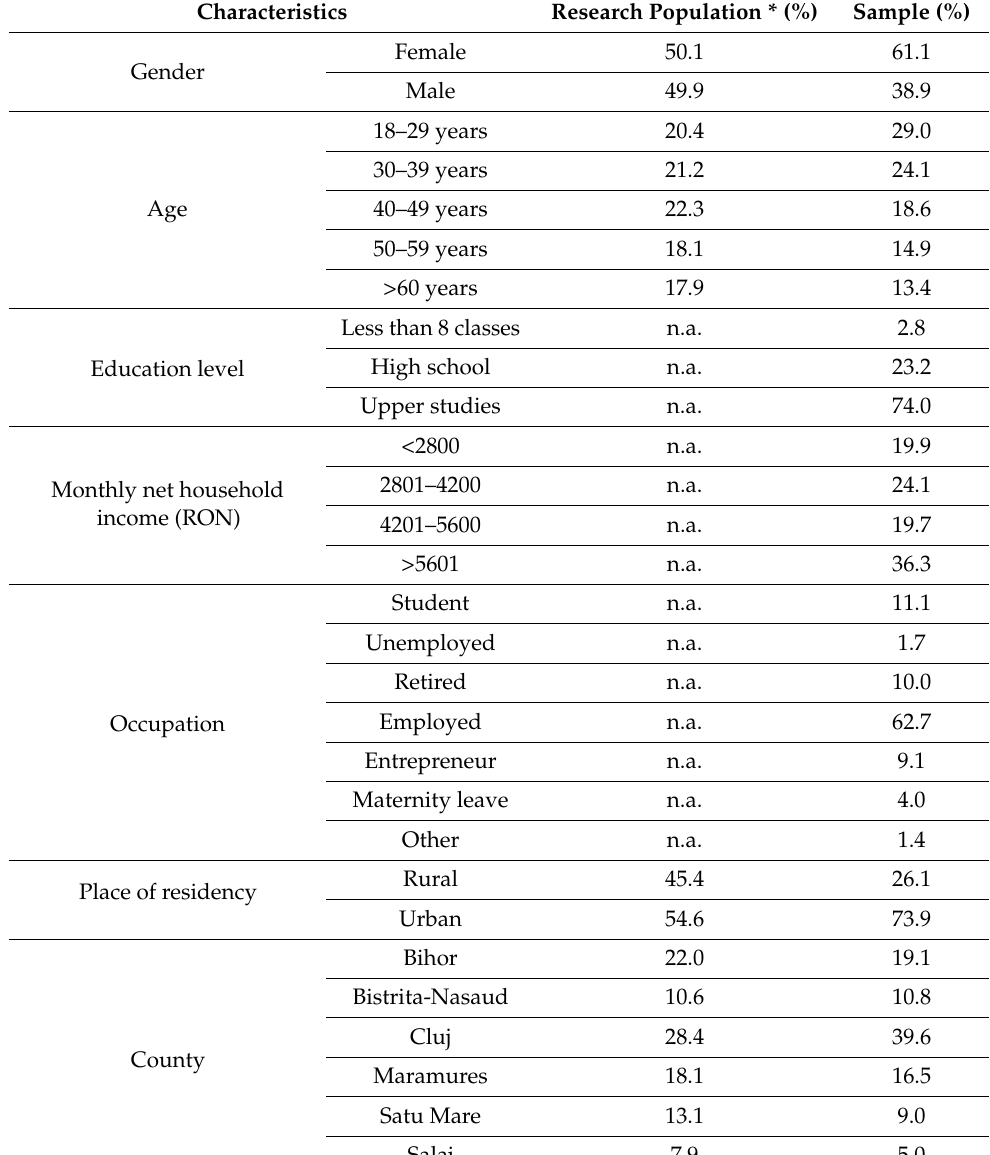
Table 1. Socio-demographic characteristics of the